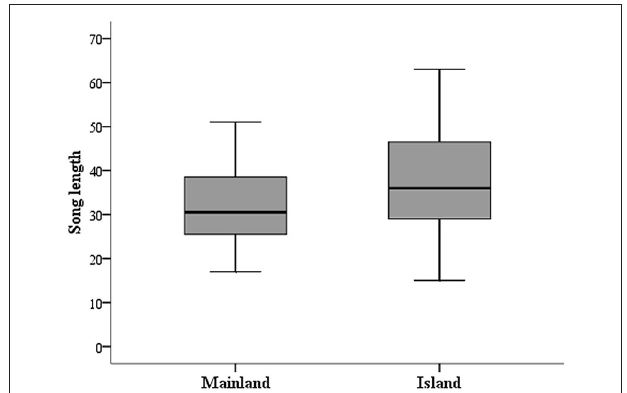
FIGURE 1 | Boxplot of female song length originating from Mainland or Island